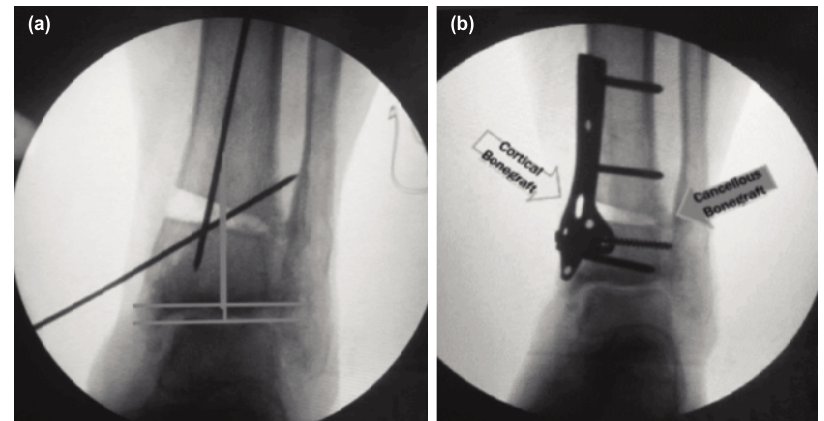
Intra-operative imaging. (a) Open wedge osteotomy on distal tibia until normal TAS angle reached; K-wire used for temporary Fig. 2: fixation. (b) Cortical allograft used to fill the gap and cancellous bone graft, fixated using plate and screw (internal documentation).